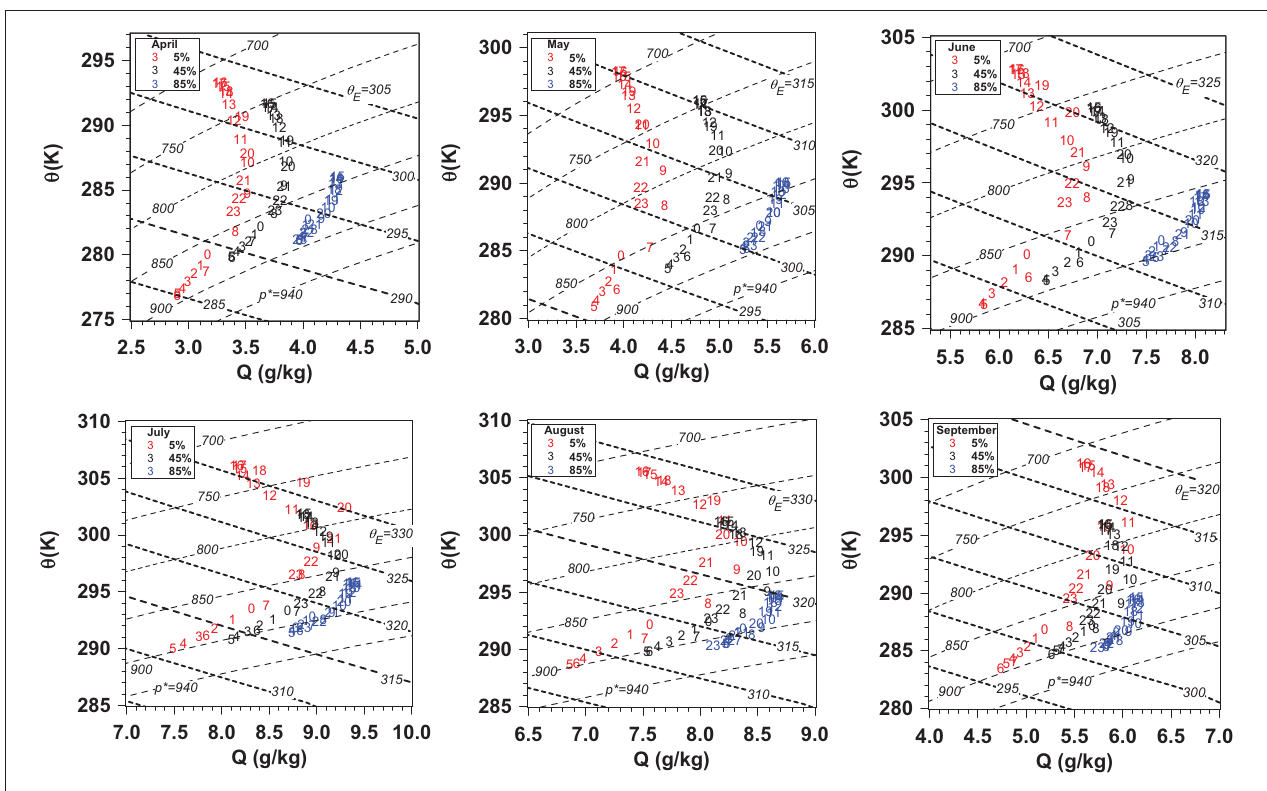
FIGURE 18 | As Figure 10 for warm season composites from April to